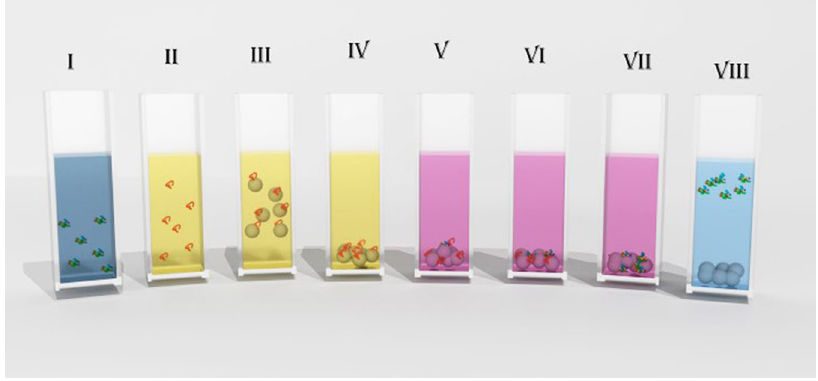
Figure 1. The alumina nanoparticle-assisted enzyme refolding process; see text for explanation of the